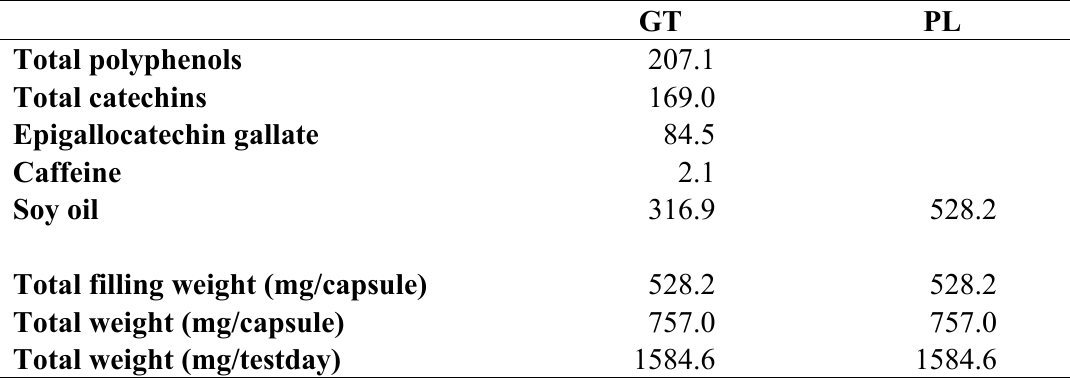
Table 1. Composition of the green tea capsules